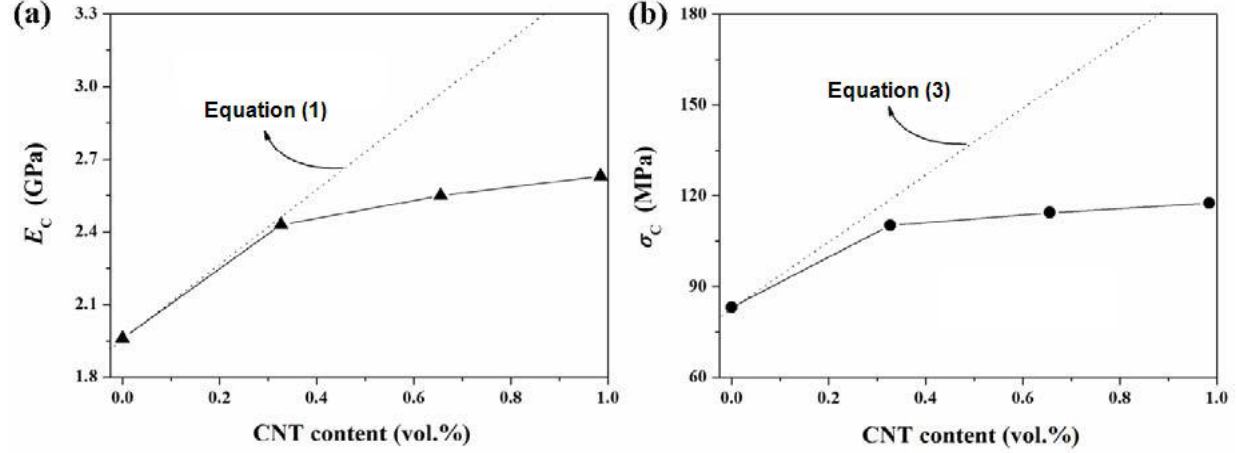
Figure 5. Comparison between the theoretical predictions (dotted line) and the experimental results (solid line) of the modulus ( a ) and of the tensile strength ( b ) for the MWCNT/TLCP composites